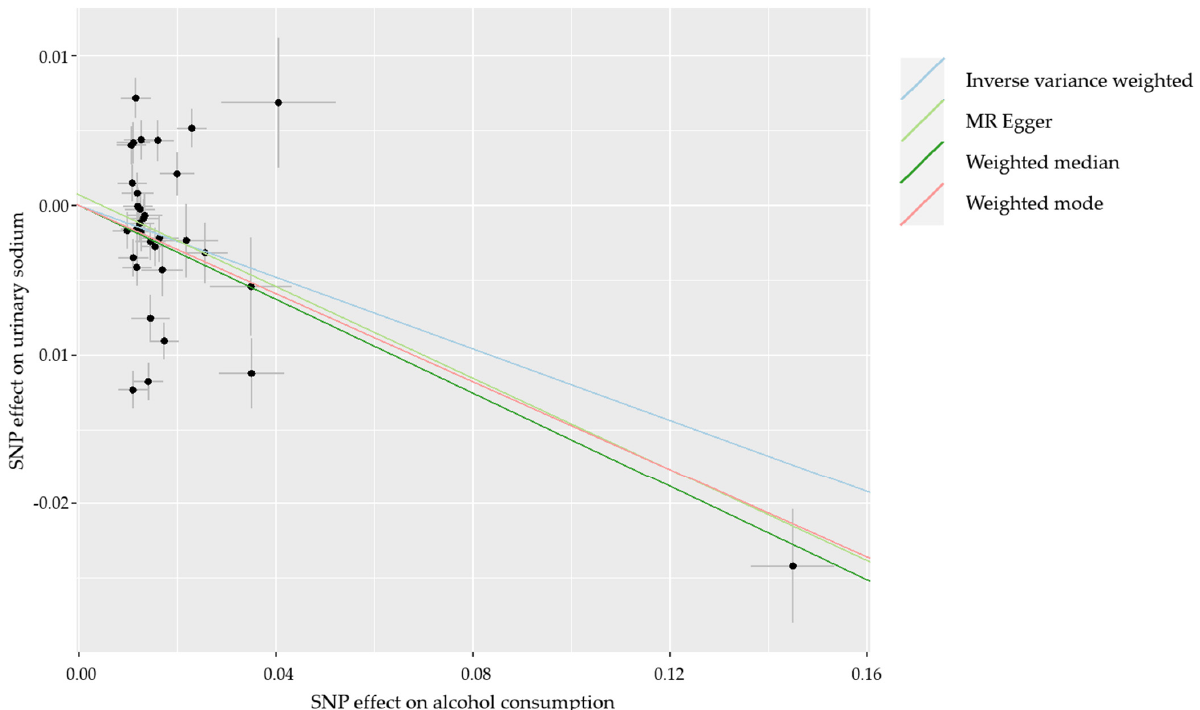
Figure 5. Two-sample MR for the relationship between alcohol consumption and urinary sodium. Lines represent regression line for various MR tests used. Black dots with cross represent each SNP. Effect of SNPs on alcohol consumption and urinary sodium are in the logarithmic scale. SNP, single nucleotide polymorphism; MR, Mendelian randomization.